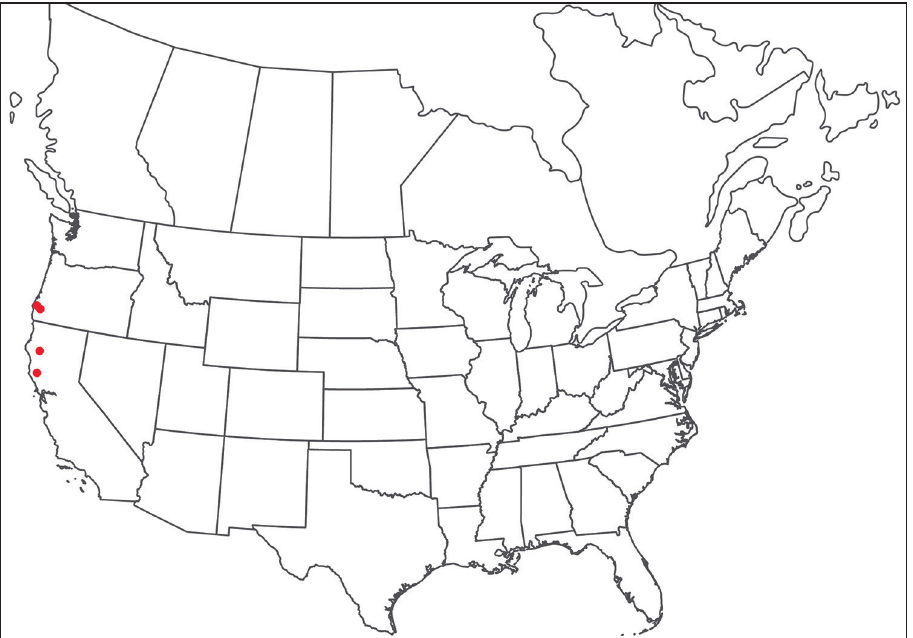
Figure 190. Torrenticola pinocchio sp. n.